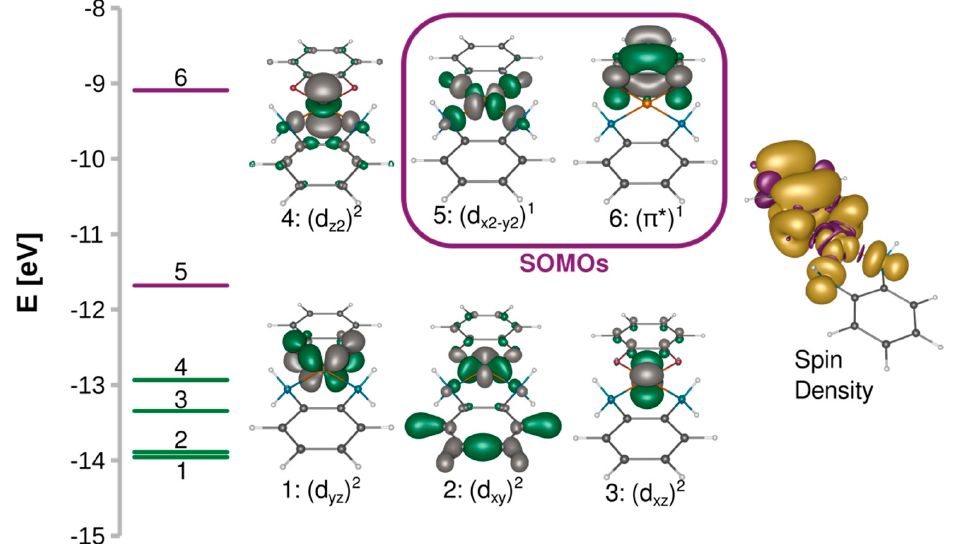
Figure 2. Splitting of the quasi-restricted orbitals and their isosurfaces contoured at 0.05 a.u. and spin density isosurfaces contoured at 0.001 a.u. calculated at the B3LYP/def2-TZVP level for [Cu(SQ)(opd)] + .